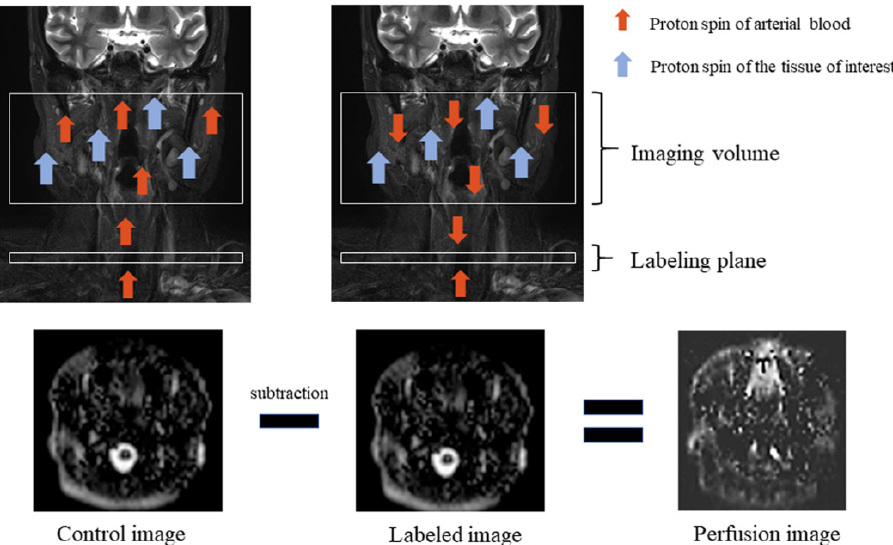
Figure 1. Arterial spin labeling scheme. Perfusion imaging requires control and labeled images. Proton spin of arterial blood is inverted, which is called labeling, by using radio frequency (RF) pulses in the labeling plane. Total magnetization is reduced when labeled blood travels to the tissue of interest which has its proton spin, and labeled image volume is obtained during this moment. Then, the labeled image is subtracted from the obtained control image without RF pulses, and a perfusion image is obtained.